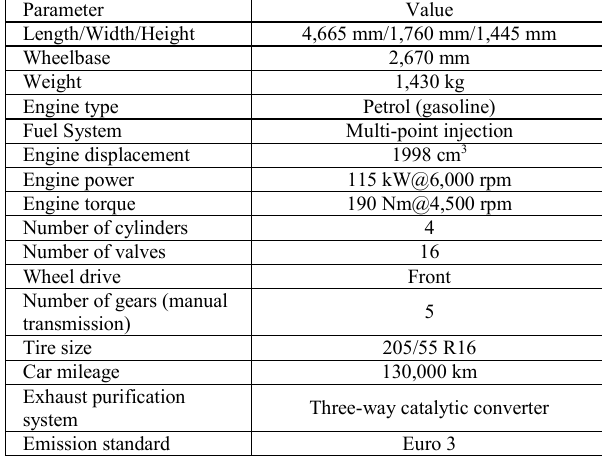
Table 2. Technical data of the vehicle